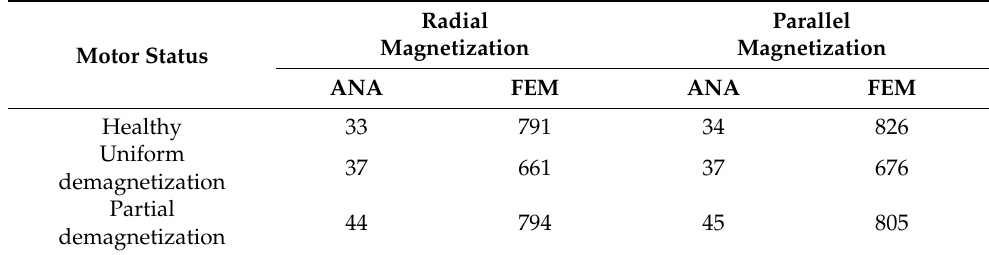
Table 6. Computation time comparison at rated load (Unit: